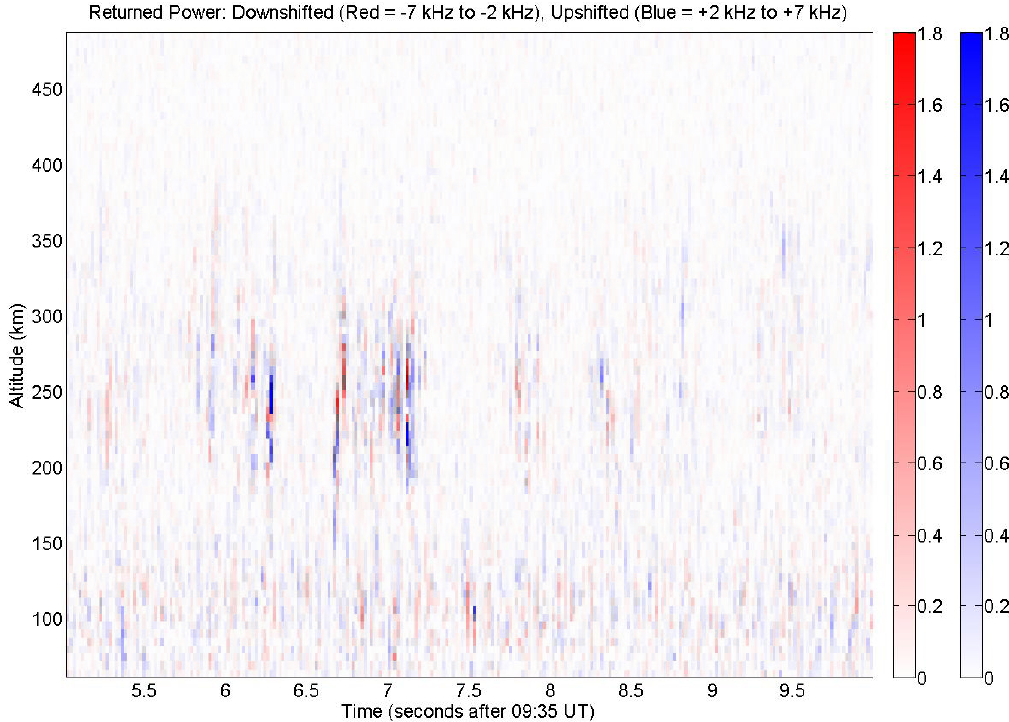
Fig. 6. Summary of the returned power in the NEIALs from the raw data as a function of time and altitude, broken down into two frequency ranges, enhanced up-shifted shoulders (2 to 7kHz, shown in blue) and enhanced down-shifted shoulders ( − 7 to − 2kHz shown in red). Again, these raw data are not corrected for the 1 decrease in power with r 2